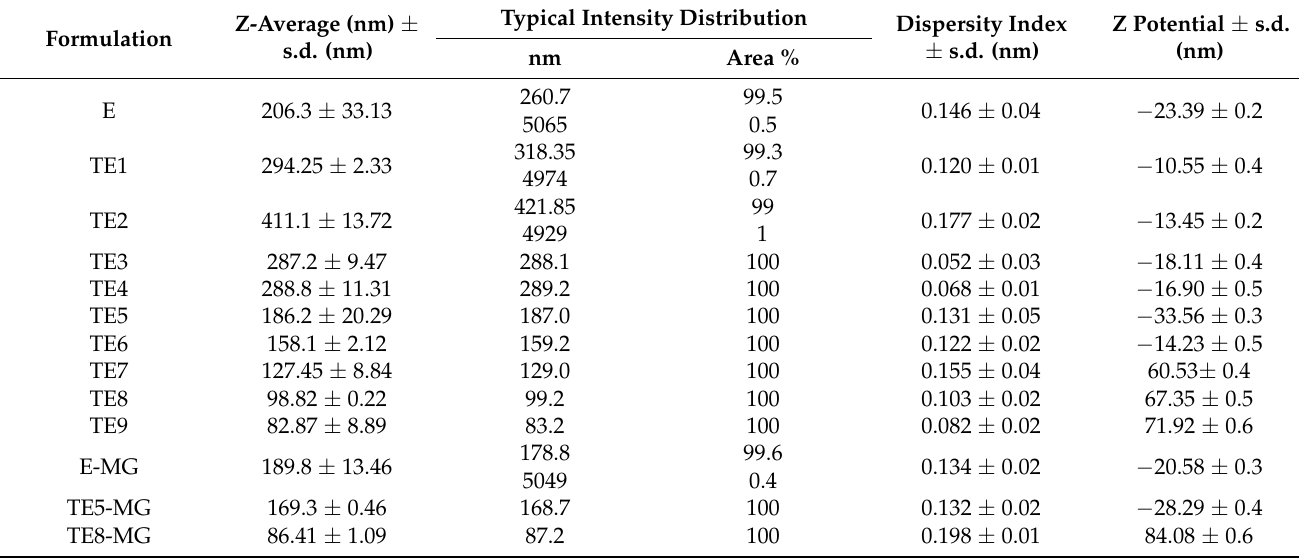
Table 3. Dimensional distribution parameters of ethosomes and transethosomes, as determined by PCS.